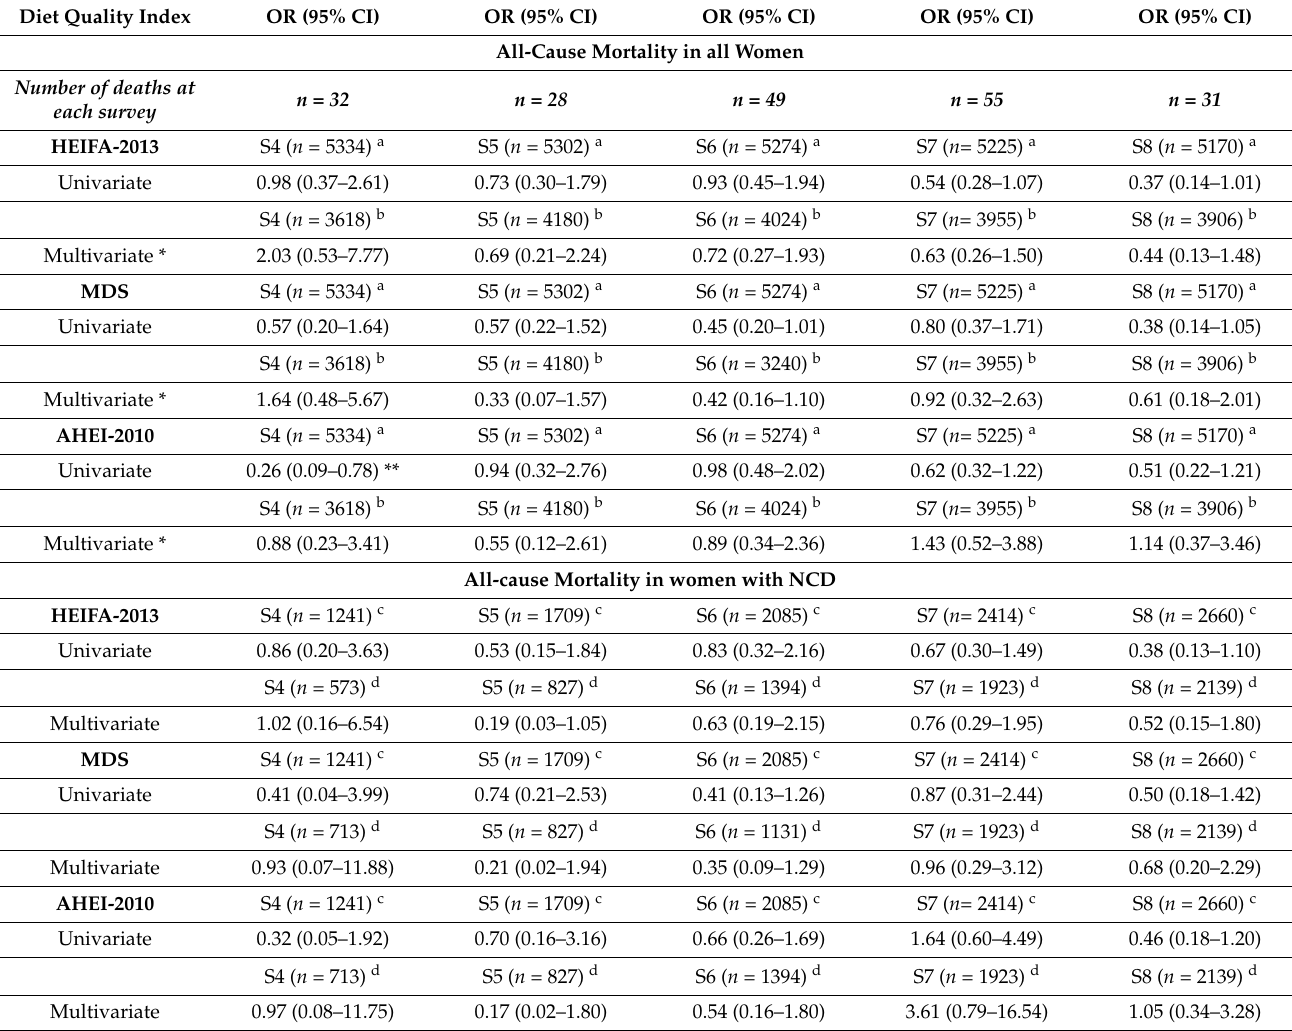
Table 3. Associations between diet quality indices and risk of all-cause mortality among 1946–51 ALSWH cohort women (from S4 to